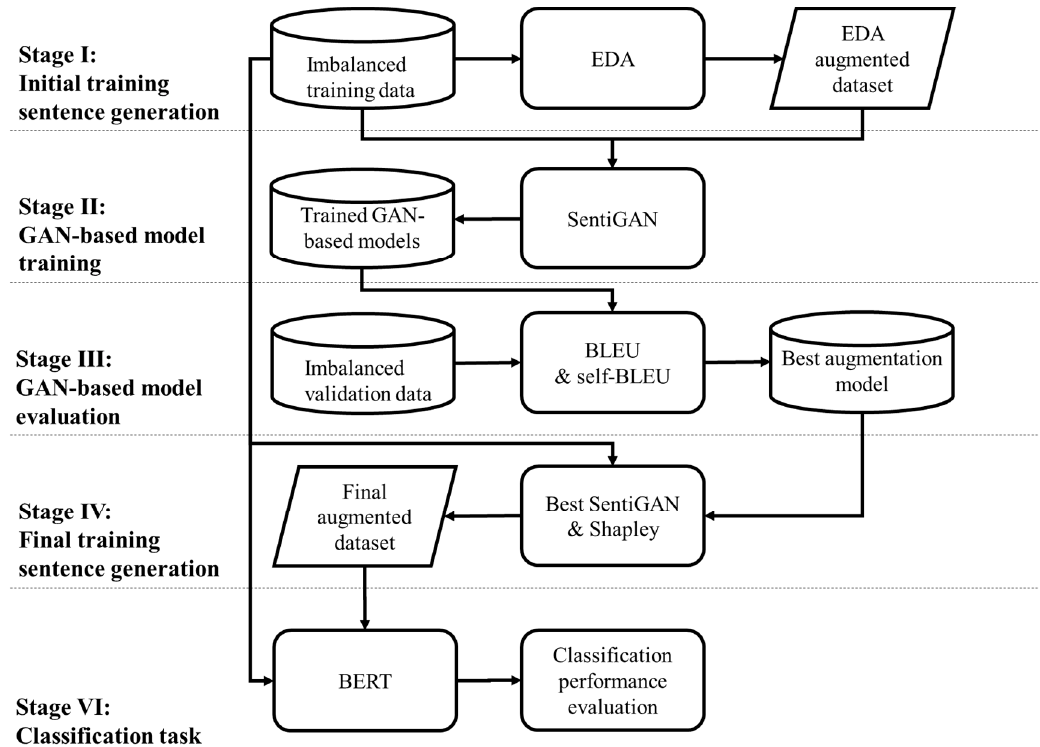
Figure 1. The flowchart of proposed HEGS framework.